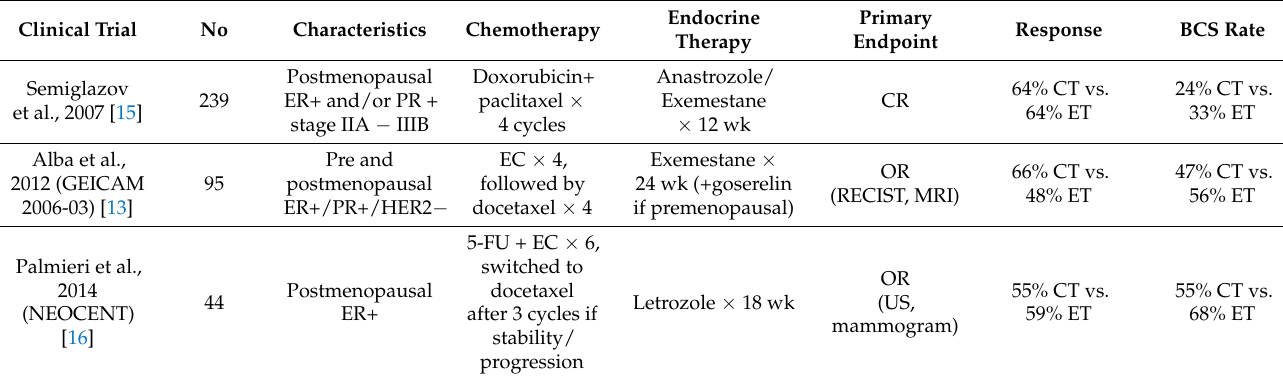
Table 1. Clinical trials comparing NET vs.